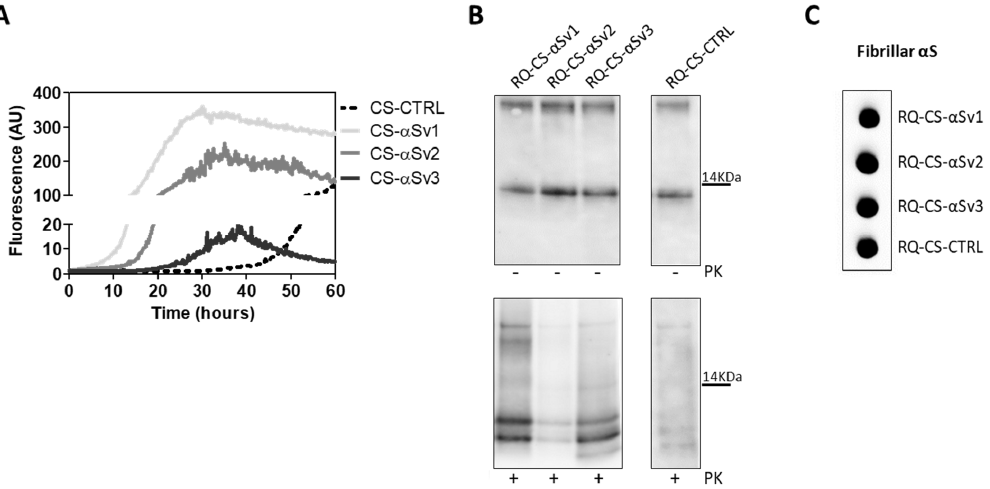
Figure 8. ( A ) α Syn_RT-QuIC analysis of CS- α Sv1, CS- α Sv2 and CS- α Sv3. All samples triggered a seeding activity when tested by α Syn_RT-QuIC. Curves represented in the graph were obtained by plotting the average fluorescence intensities of each sample against time. ( B ) Western blot analysis of untreated or PK digested α Syn_RT-QuIC products, collected at 60 h. Undigested samples showed the same biochemical profiles. PK treatment of α Syn_RT-QuIC products (RQ-CS- α Sv1, RQ-CS- α Sv2 and RQ-CS- α Sv3 and RQ-CS-CTRL) showed that the samples were characterized by similar biochemical profiles, resulting in the formation of three PK resistant bands migrating between 3 and 14 kDa. Membranes were immunoblotted with the AS08 358 antibody. Number on the right indicates the molecular weight. ( C ) Dot blot analysis of α Syn_RT-QuIC products, collected at 60 h. Dot blot analysis performed using the MJFR antibody showed the presence of a strong signal in all the samples.